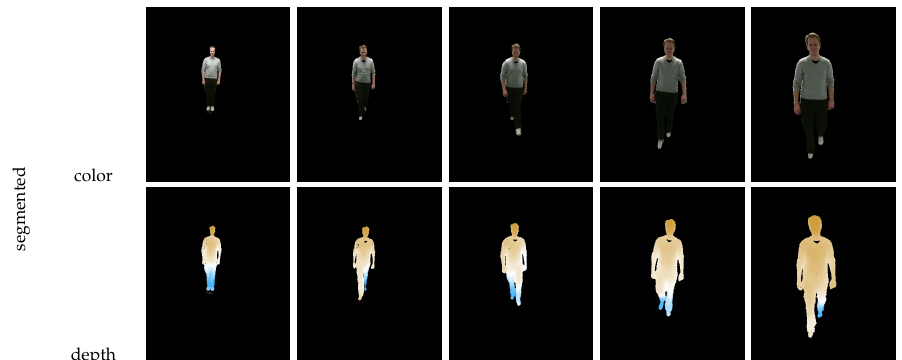
Figure 6. Sequence of someone walking towards the camera: The first two rows in the table illustrate the raw scene in color and depth representation, while the lower part of the table shows the segmented person. The sequence was recorded over four to five seconds. The scene is recorded with the Kinect